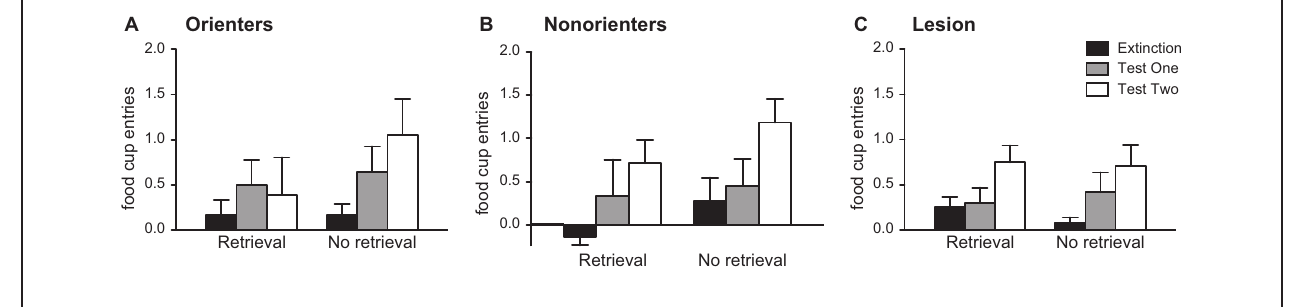
FIGURE 7 | Mean ( ± SEM) food-cup responding during extinction and tests both 24-h (Test 1) and 21 days (Test 2) after extinction . The values are responses during the last two CS alone presentations of the extinction